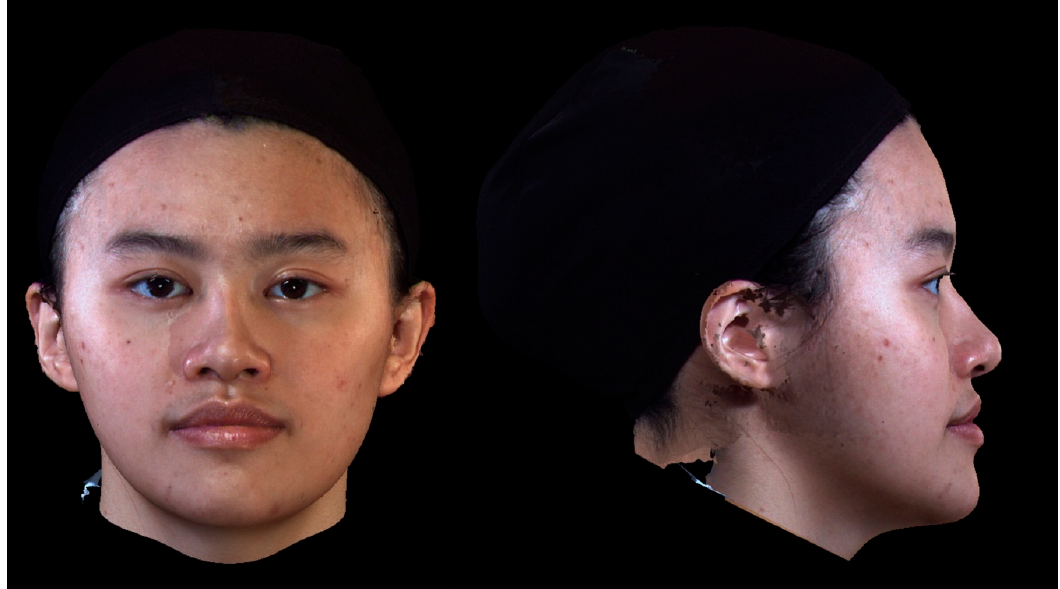
Figure 3. An example of a three − dimensional facial image of a female patient with a skeletal class III deformity post − orthognathic surgery. On panel assessment, the average perceived facial personality traits were: 4.7, 4.4, and 4.8 (lay observer, orthodontic professional, and surgical professional, respectively); 4.8, 5.1, and 4.7; 3.1, 3.5, and 3.4; 5.1, 4.9, and 5.3; and 5.2, 4.9, and 5.4 for the intelligent, friendly, threatening, trustworthy, and dominant parameters, respectively.